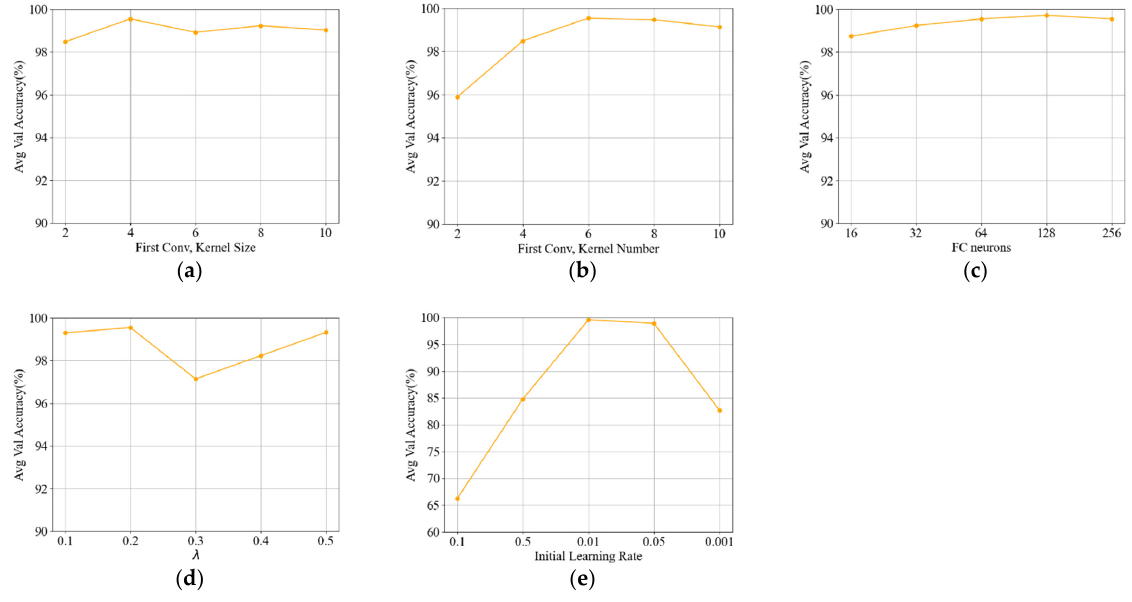
Figure 7. Effects of different parameters on the framework performance. ( a ) Kernel size of the first convolution layer; ( b ) kernel number of the first convolution layer; ( c ) neurons of the FC layer; ( d ) λ ; ( e ) initial learning rate.